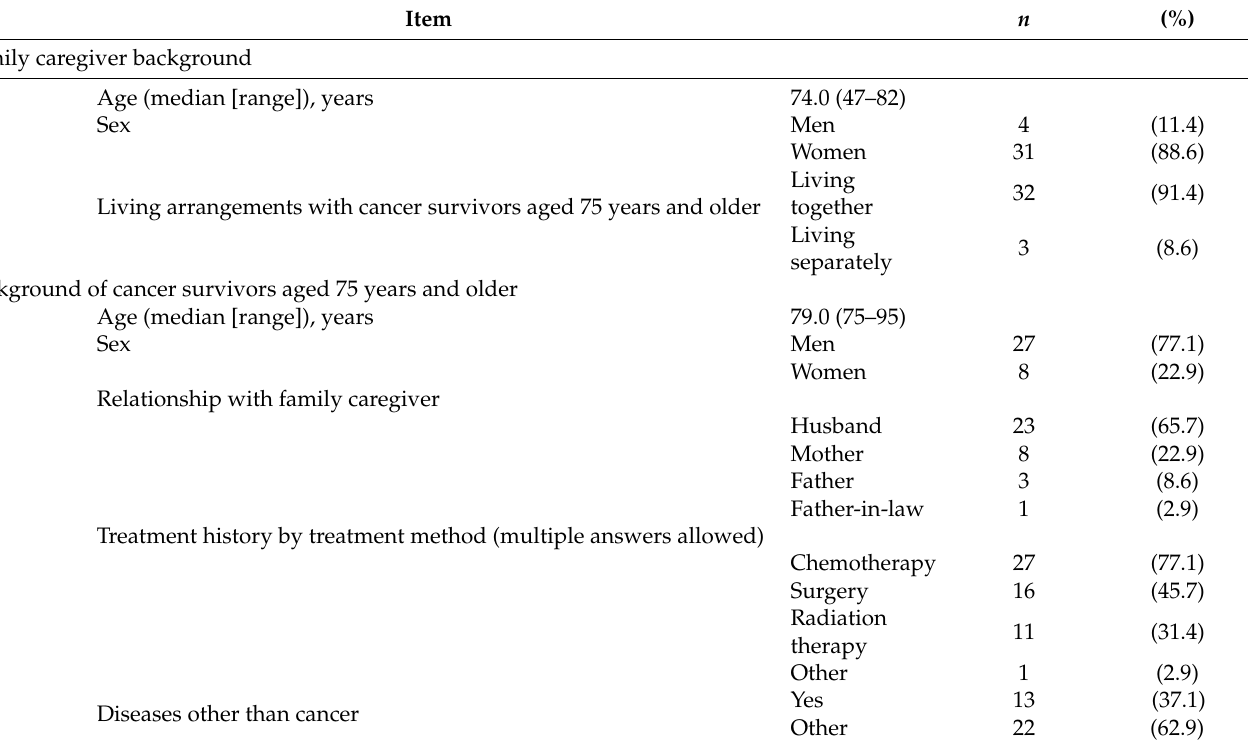
Table 1. Background of family caregivers and cancer survivors over 75 years (n =